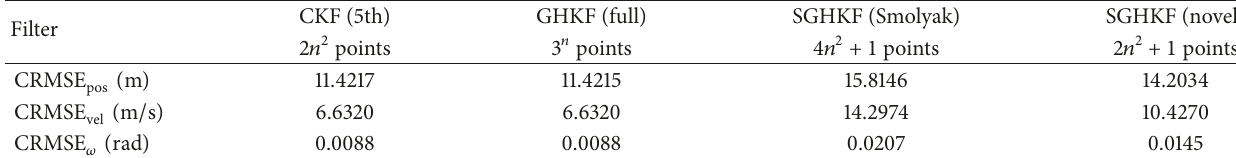
Table 3: CRMSE of different filters.